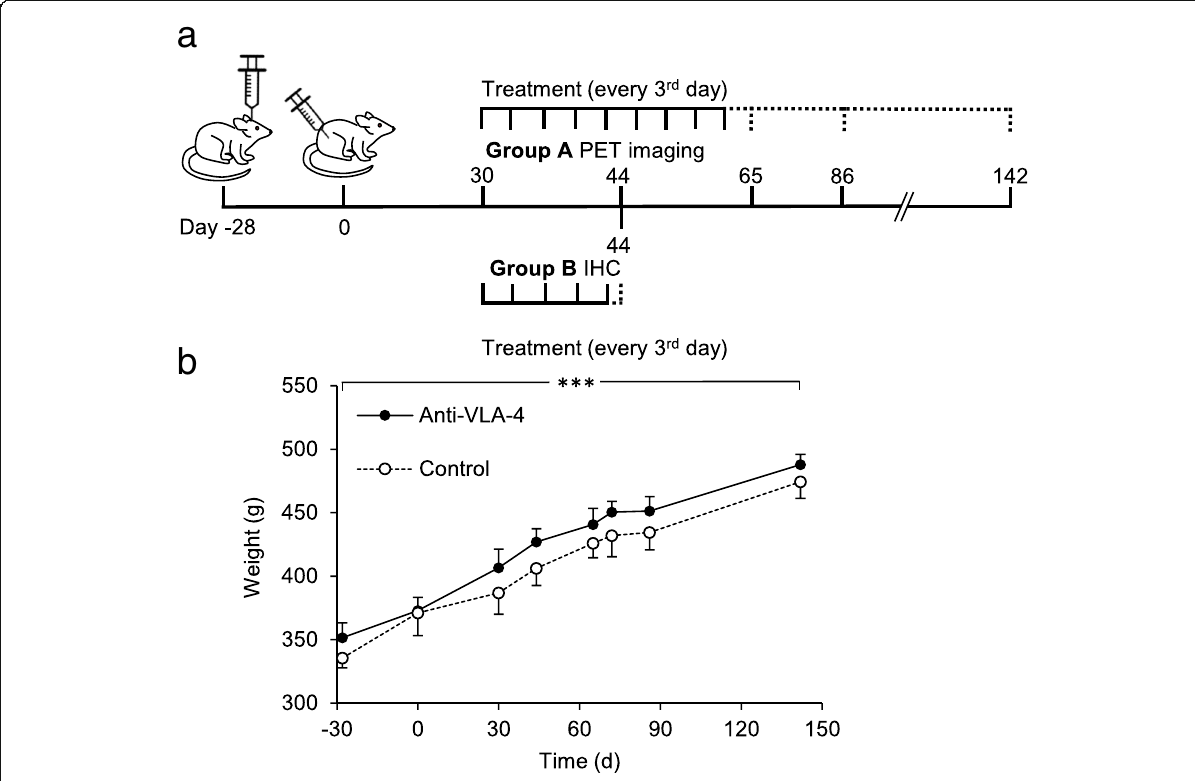
Fig. 1 A schema of the experimental design showing the timeline of the procedures and changes in the rats ’ body weight during the study. a Stereotaxic operation with BCG was performed on day − 28 (group A, n =8 and group B, n =4). Activation of the lesion was performed on day 0. Animals in group A were treated every third day with anti-VLA-4 mAb ( n =4) or with an isotype matched control mAb ( n =4) on days 30 – 61. The dashed line indicates the follow-up period after treatment. PET images were acquired on days 30, 44, 65, 86 and 142. Animals for IHC were treated every third day during days 30 – 44 and were killed on day 44 (group B). b Changes in the body weight of the animals during the PET imaging study. Results are shown as means (SD). *** p <0.001; BCG Bacille Calmette-Guérin, IHC immunohistochemical, mAb monoclonal antibody, PET